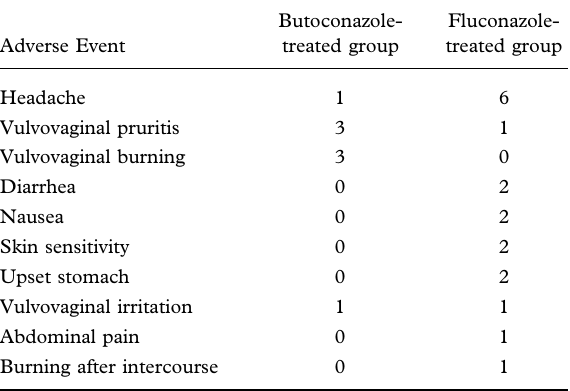
Table III. Most common patient-reported adverse events, drug- related. Adverse Event